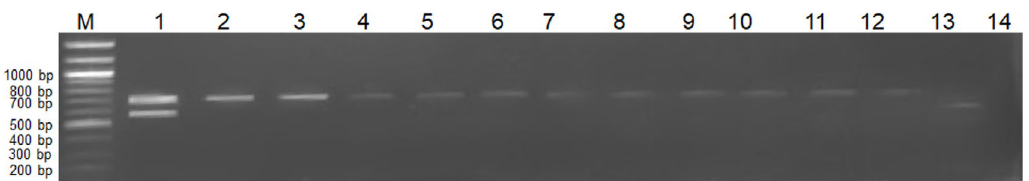
Fig. 3. Multiplex PCR with pathogenic and saprophytic cultures Lane M: 100bp Marker, 1: Lipl32 and Lipl21 plasmid (positive control). 2: L. interrogans ser. Icterohaemorrhagiae , 3: L. interrogans ser. Hebdomadis, 4: L. interrogans ser . Pyrogens , 5: L. interrogans ser. Sejroe , 6: L. kirschneri ser. S Grippotyphosa, 7: L.interrogans ser. Bataviae , 8: L. interrogans ser. Canicola , 9: L. borgpetersenii ser. Ballum , 10: L.interrogans ser. Pomona , 11: L. interrogans ser. Autamnalis , 12: L interrogans ser. Australis , 13: L.meyeri ser. Semarangaa , 14: Negative